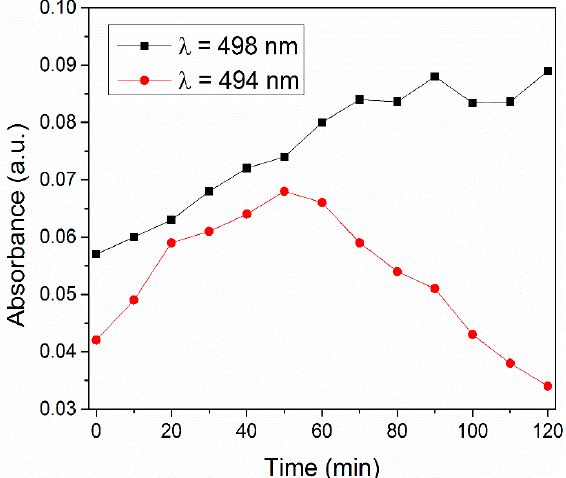
Figure 14. Rh110 absorbance vs. time for catalytic ( λ = 498 nm) and photocatalytic ( λ = 494 nm) reactions over α -MnO 2 .